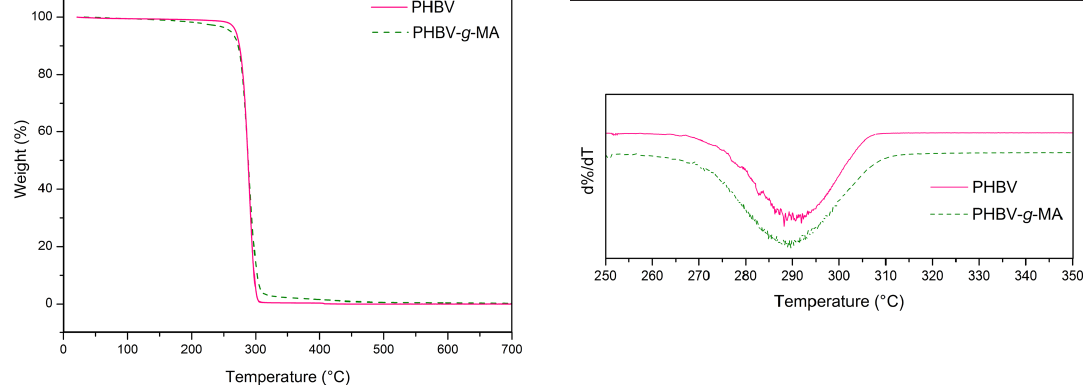
Figure 5. First derivative thermogravimetric curve from neat PHBV and PHBV - g - MA.